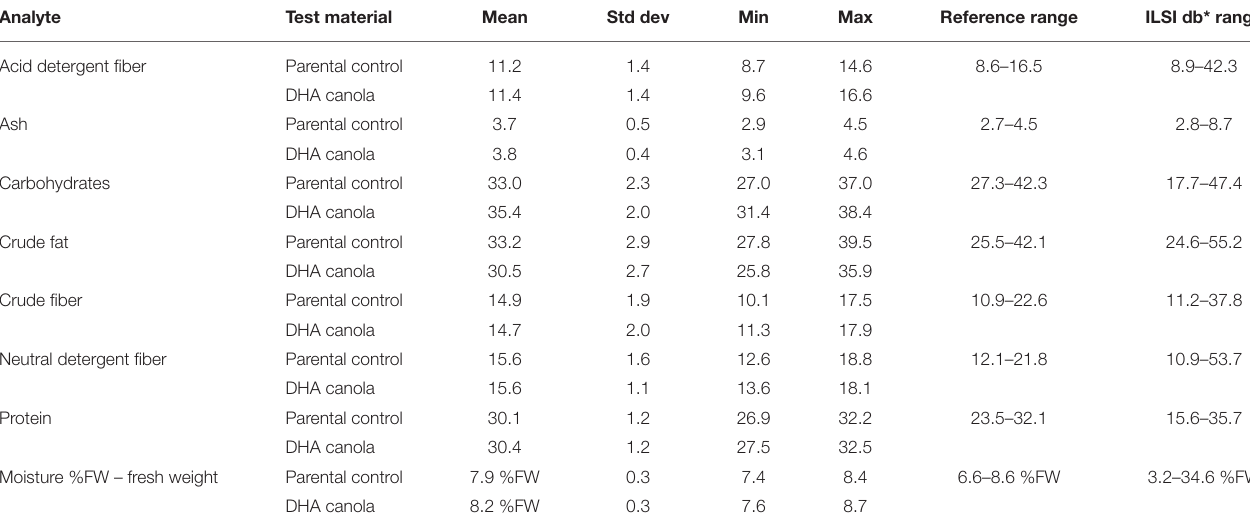
TABLE 1 | Proximate analysis of DHA canola grain (% DW unless noted otherwise).